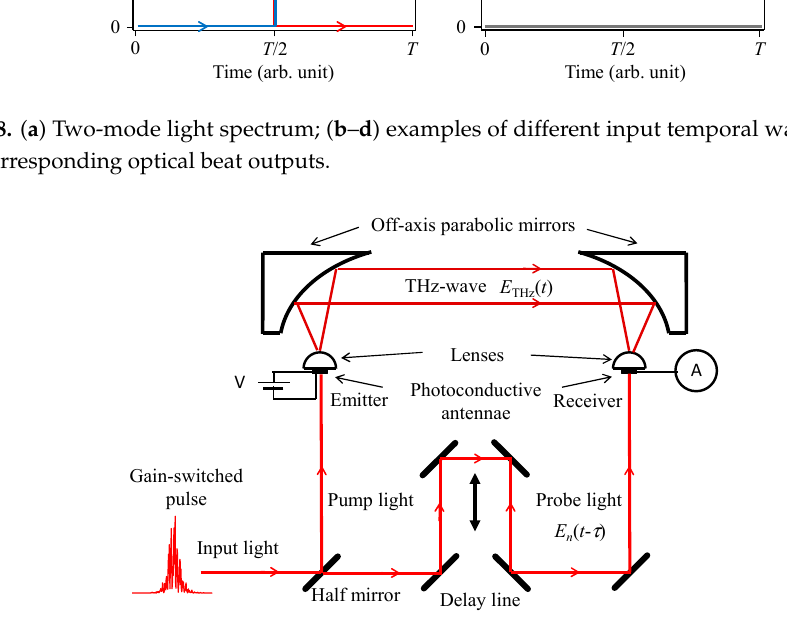
Figure 9. Schematic diagram of THz-TDS (time-domain spectroscopy) system.